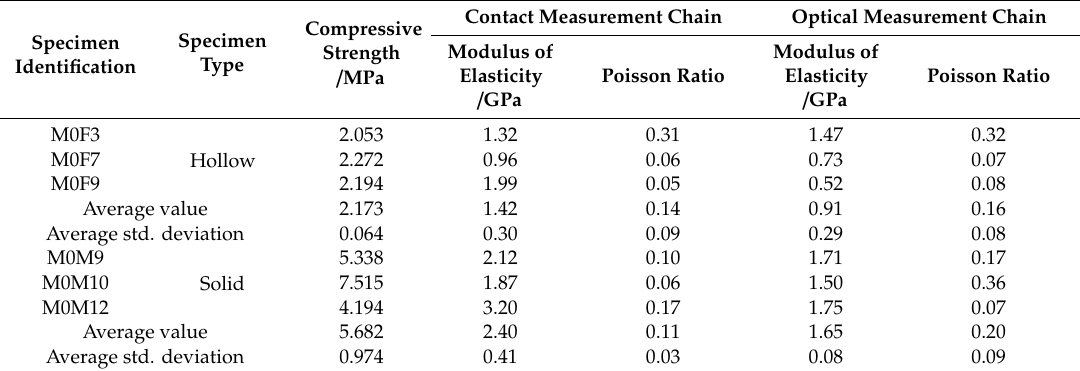
Table 5. Mechanical properties estimates of some tested masonry